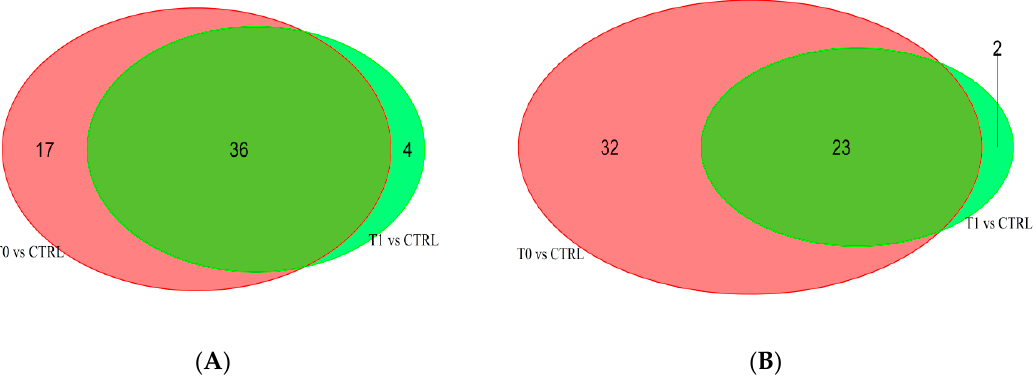
Figure2. Shareanduniquerelevantvariables. ( A )Resultsforthedatasetobtainedbynegative-ionization Figure 2. Share and unique relevant variables. ( A ) Results for the dataset obtained by negative- mode; ( B ) results for the dataset from positive-ionization ionization mode; ( B ) results for the dataset from positive-ionization mode.